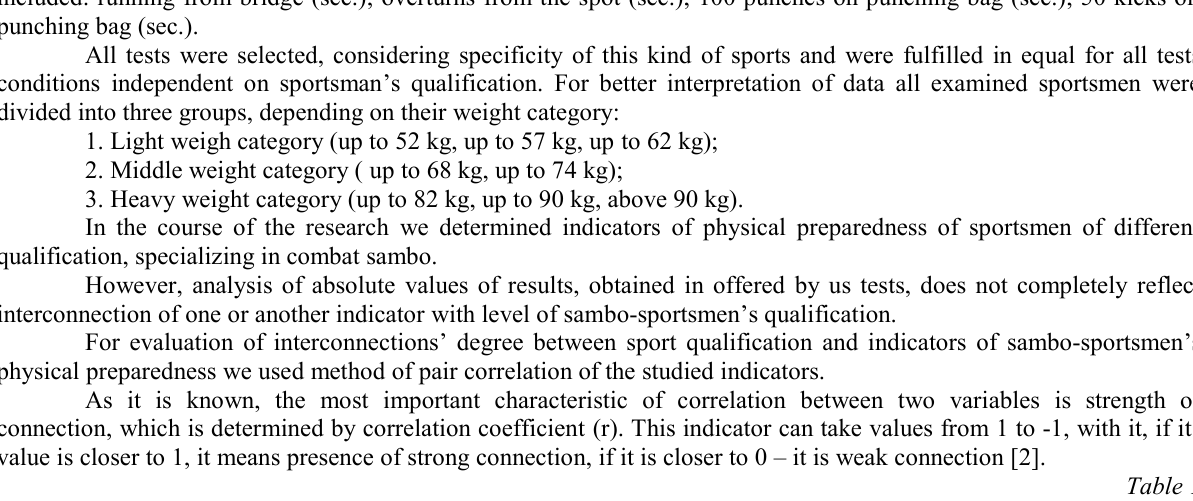
Correlation interconnection of sport qualification and testing results of sambo sportsmen’s